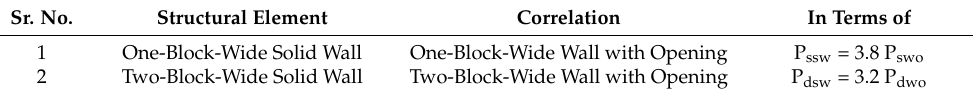
Table 4. Correlation between load carrying capacity of solid walls and walls with door opening. Sr.